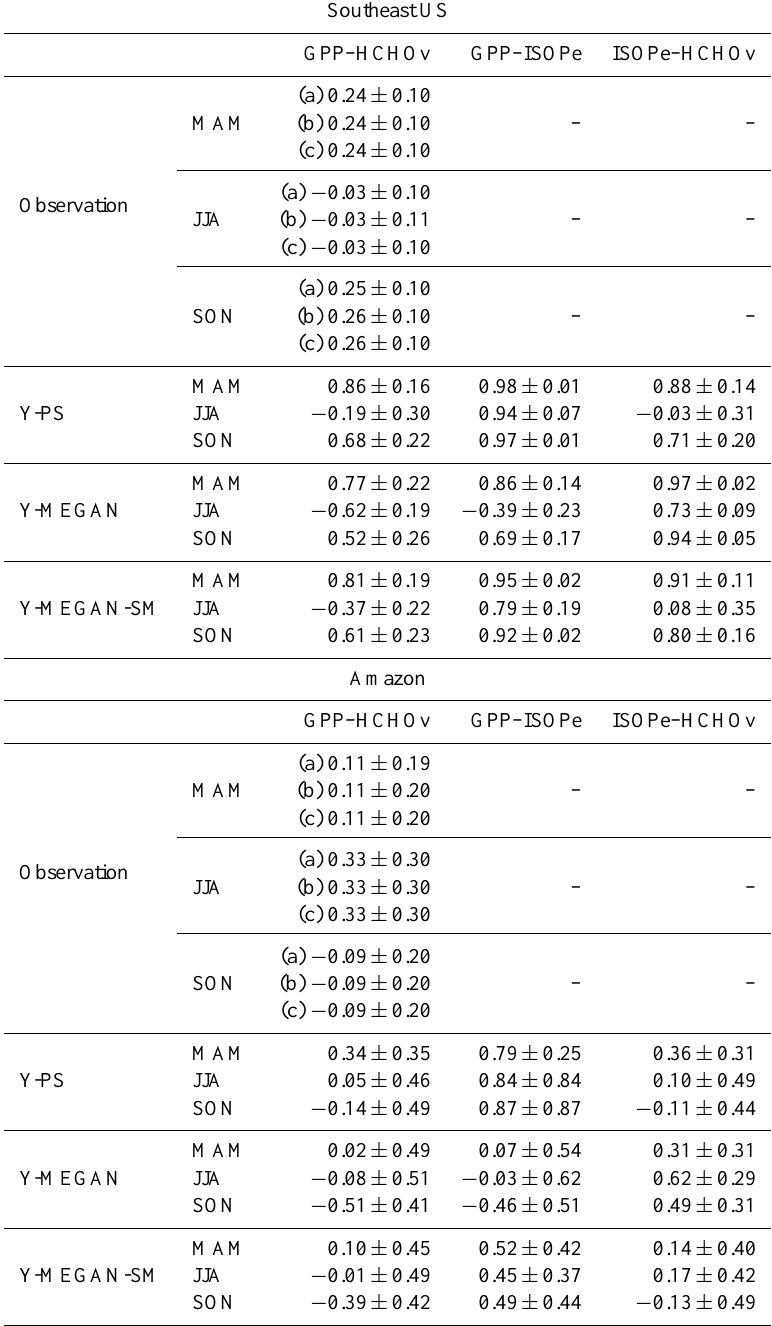
Table 3. Summary of regionally averaged observational and simulated seasonal correlation coefficients in the southeast US and the Amazon. In observational GPP–HCHOv (a), (b) and (c), the OMI HCHO columns are processed using model Y-PS, Y-MEGAN and Y-MEGAN-SM, respectively.